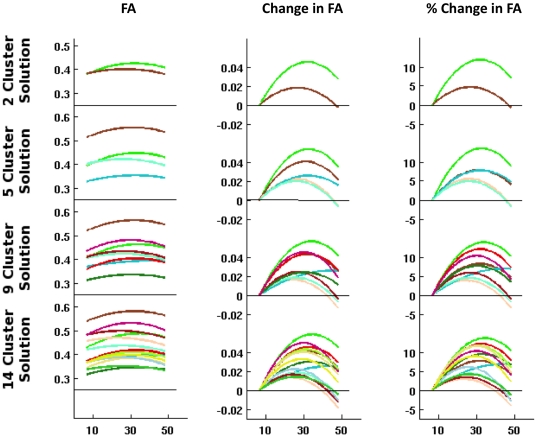
Absolute Trajectories and Relative Changes of Skeletonized Fractional Anisotropy (FA) Values.The trajectories for the 2-, 5-, 9- and 14-cluster solutions (from top to bottom) are depicted as absolute FA values (left column; ordinate shows FA absolute values), FA difference from initial trajectory value (middle column; ordinate shows relative FA change in absolute units), and percent change in FA relative to initial value (right column; ordinate shows percent change in FA). Abscissas show age in years. Initial FA trajectory value and percent change in FA were not significantly related across any of the clusters.